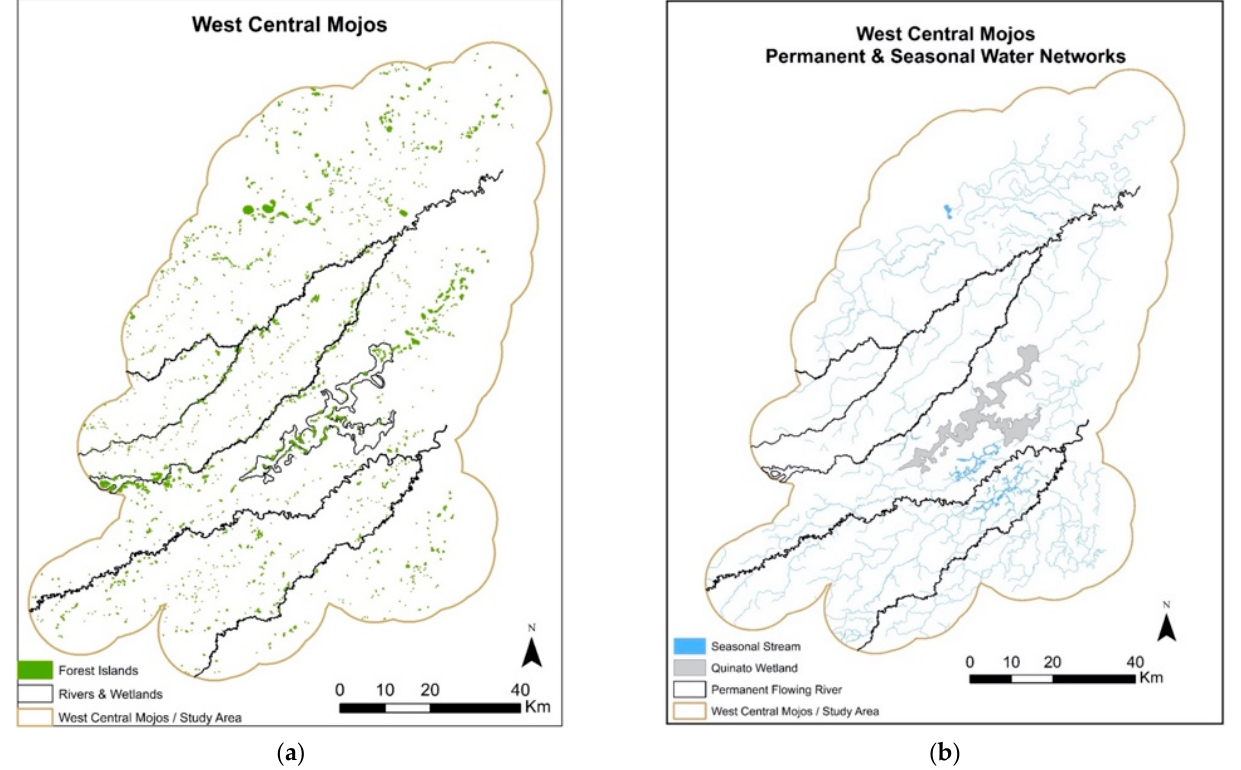
Figure 4. ( a ) 1940 polygons representing 8786.4 ha of Forest Island were mapped. Forest Islands are isolated patches of forest that are generally round to irregular in shape and are associated with slightly elevated portions of the landscape that experience less flooding; ( b ) permanent rivers and seasonal streams.